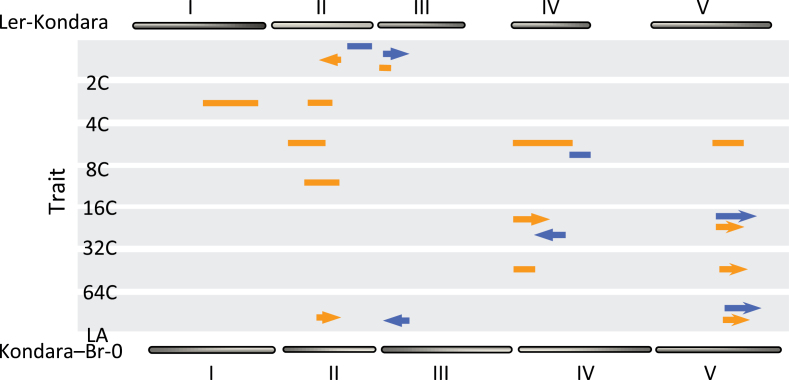
Genetic structure underlying the natural variation for endopolyploidy and leaf size in Arabidopsis. Schematic representation of co-segregated QTL for endopolyploidy and leaf area (LA) identified in the Ler-Kondara (orange bar) and Kondara-Br-0 (blue bar) populations. The length of each bar denotes 2-LOD confidence interval for the QTL on the corresponding linkage map of the RIL populations (see also Supplementary Table S5 available at JXB online). The direction of the allelic effects for the main co-segregating QTL is indicated by arrowheads (see also Supplementary Fig. S4 and Supplementary Tables S4 and S5 available at JXB online).